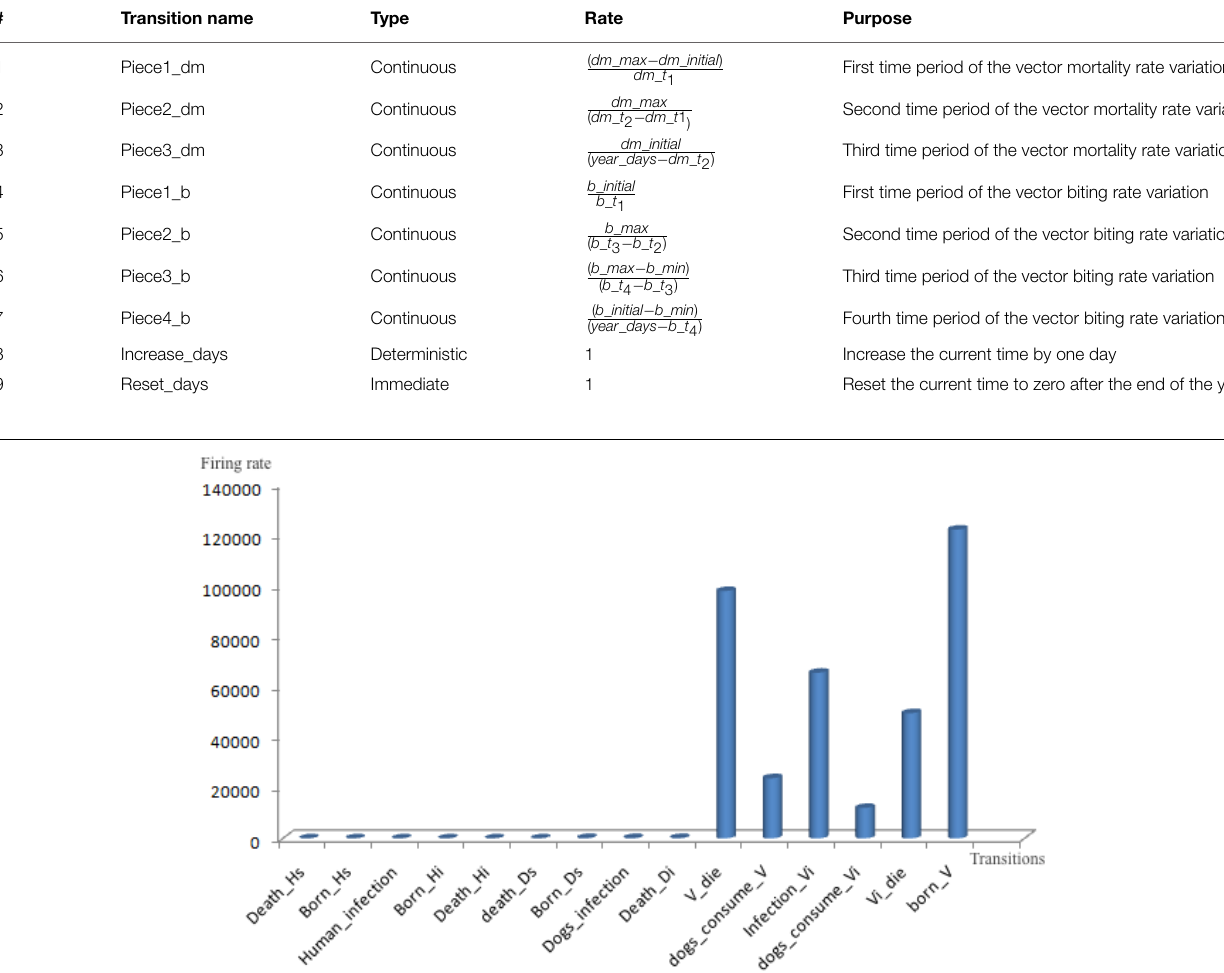
FIGURE 7 | Cumulative firing rates of each transition in the T. Cruzi model during the whole simulation period of 30 years. Transitions representing processes operating on humans and dogs are very slow compared to the other transitions operating on vectors.